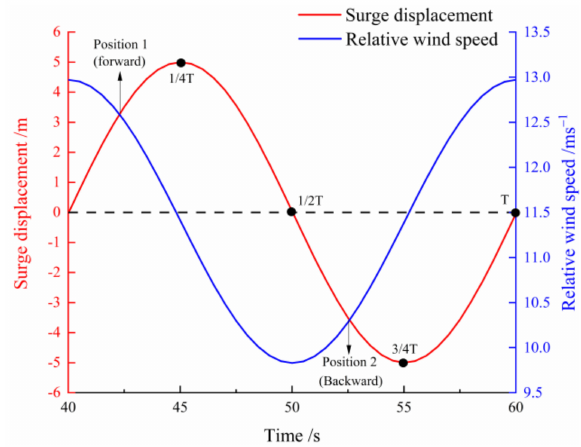
Figure 9. The two typical positions during surge